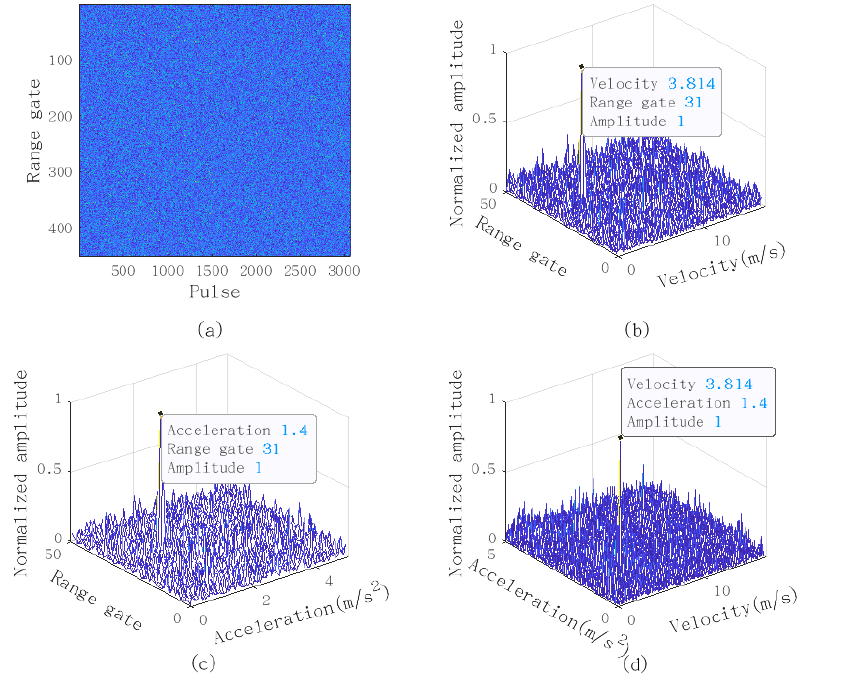
Figure 9. Real measured data processing results: ( a ) received radar signal after pulse compression; ( b ) the range–velocity slice with the acceleration being 1.4 m/s 2 ; ( c ) the range–acceleration slice with the velocity being 3.814 m/s; ( d ) the acceleration–velocity slice with the range gate being